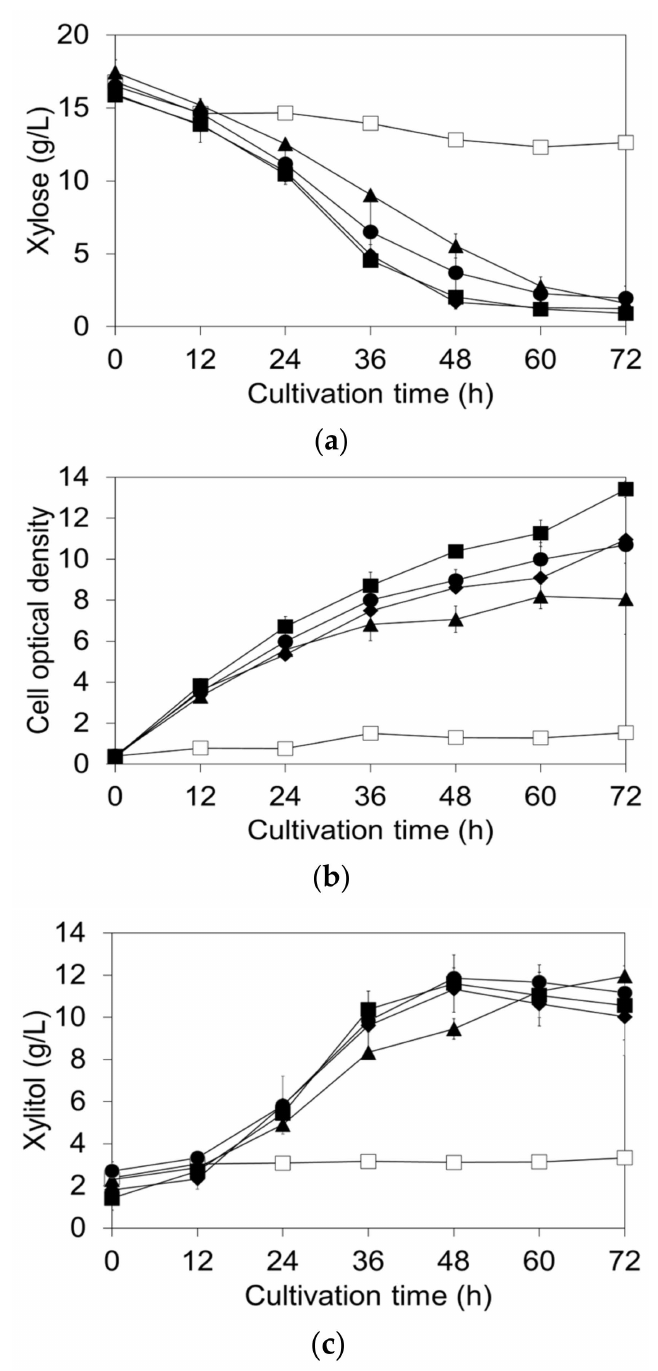
Figure 3. Profiles of ( a ) xylose, ( b ) cell optical density, and ( c ) xylitol for cultivated C. guilliermondii TISTR5068 in vinasse medium at 30 ◦ C and various aeration patterns for 72 h.